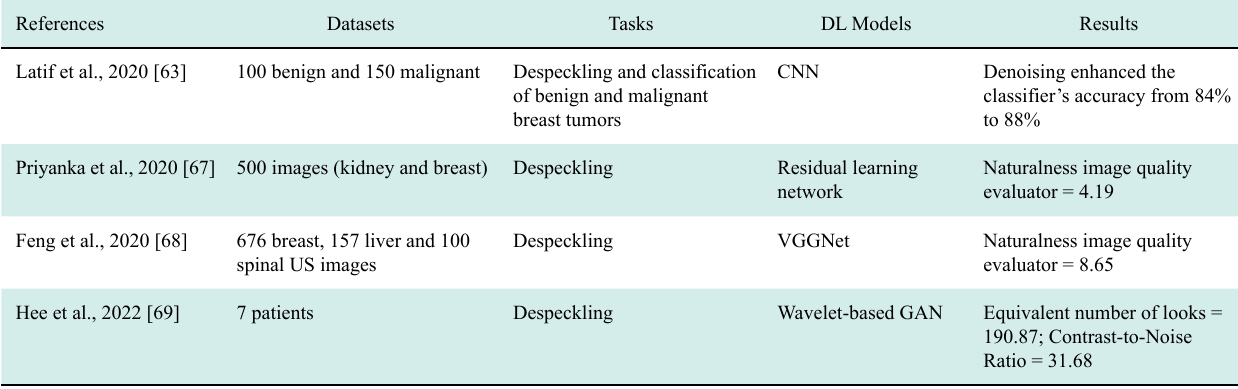
Table 1 Deep learning for despeckling in